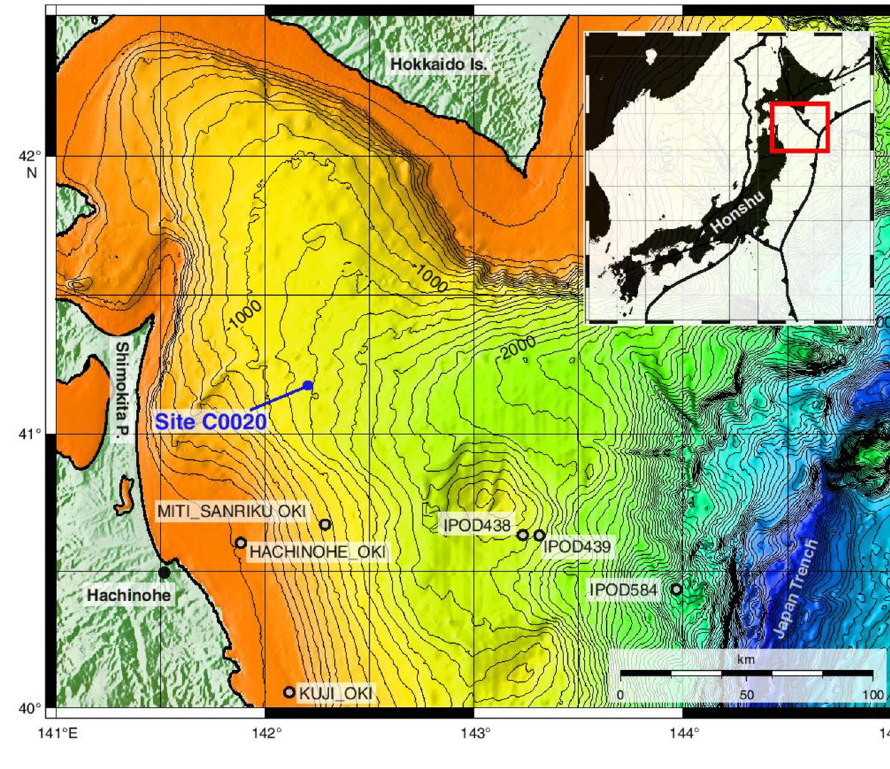
Fig. 2 Map showing the loca- tion of Field Y